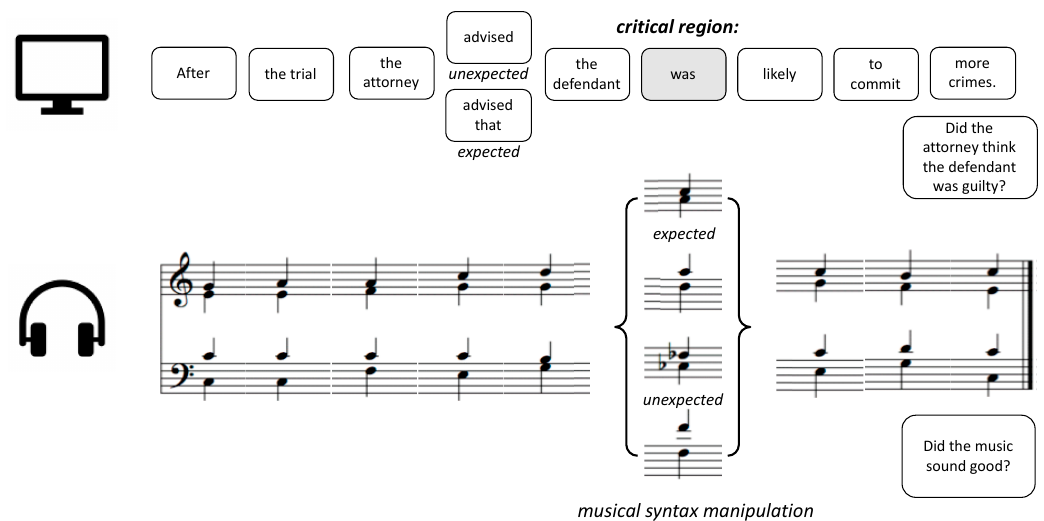
Figure 1. Example trials for Attend-language and Attend-music conditions.